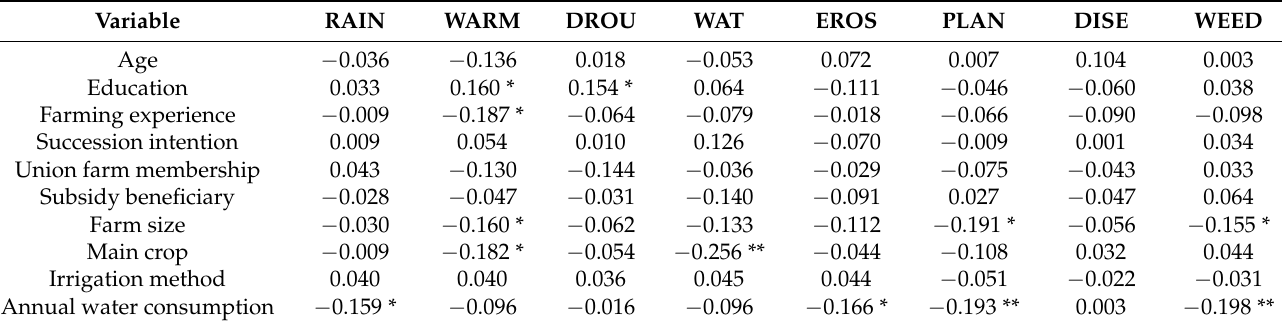
Table 6. Sociodemographic drivers of climate change perceived